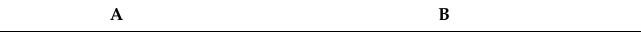
Table 9. Voce constitutive equation coefficients of material 5754O.